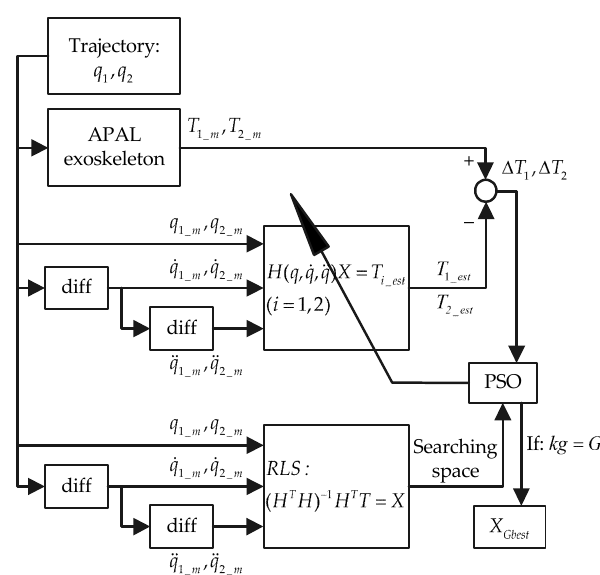
Figure 4. Flowchart of the recursive least square–particle swarm optimization (RLS-PSO) method .